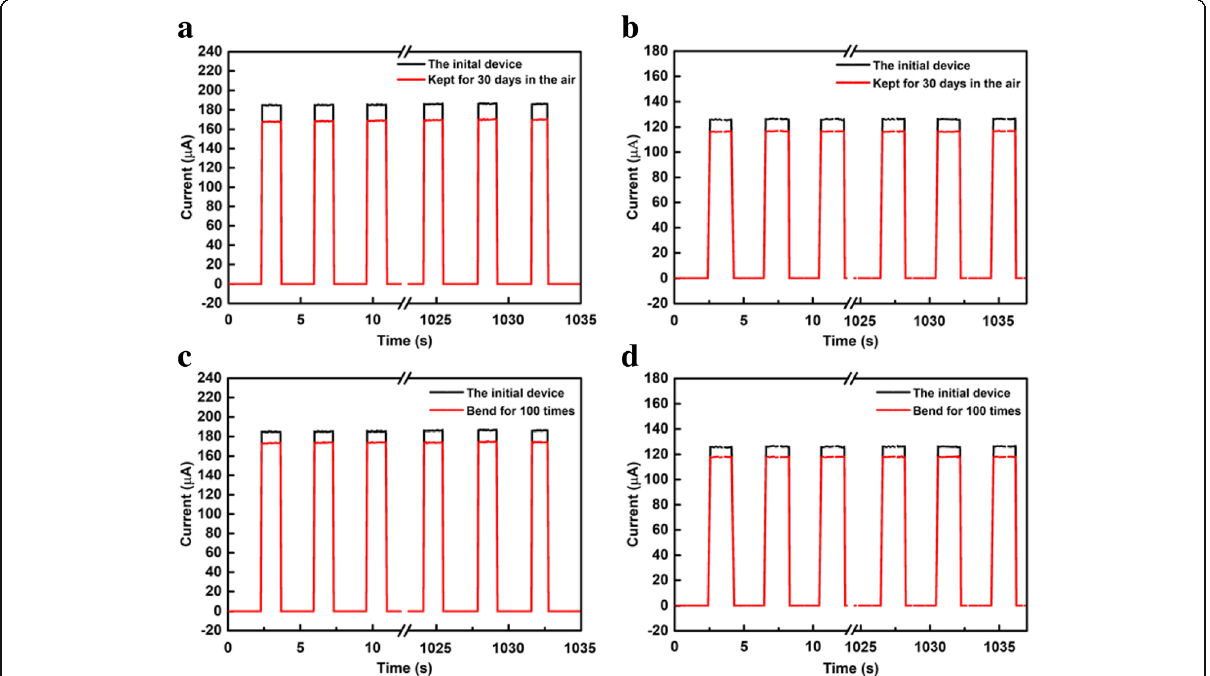
Fig. 5 Comparison of the reproducible I-t curves of a CsPbI 2 Br PDs and b CsPbIBr 2 PDs kept in air for 30 days. Comparison of the reproducible I-t curves of c CsPbI 2 Br PDs and d CsPbIBr 2 PDs bending for 100